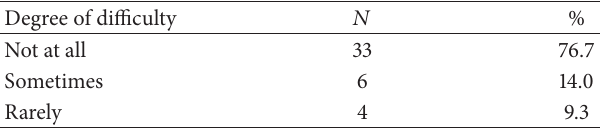
Table 7: Difficulty in adherence due to treatment regimen of co- morbid conditions ( 𝑁 = 43